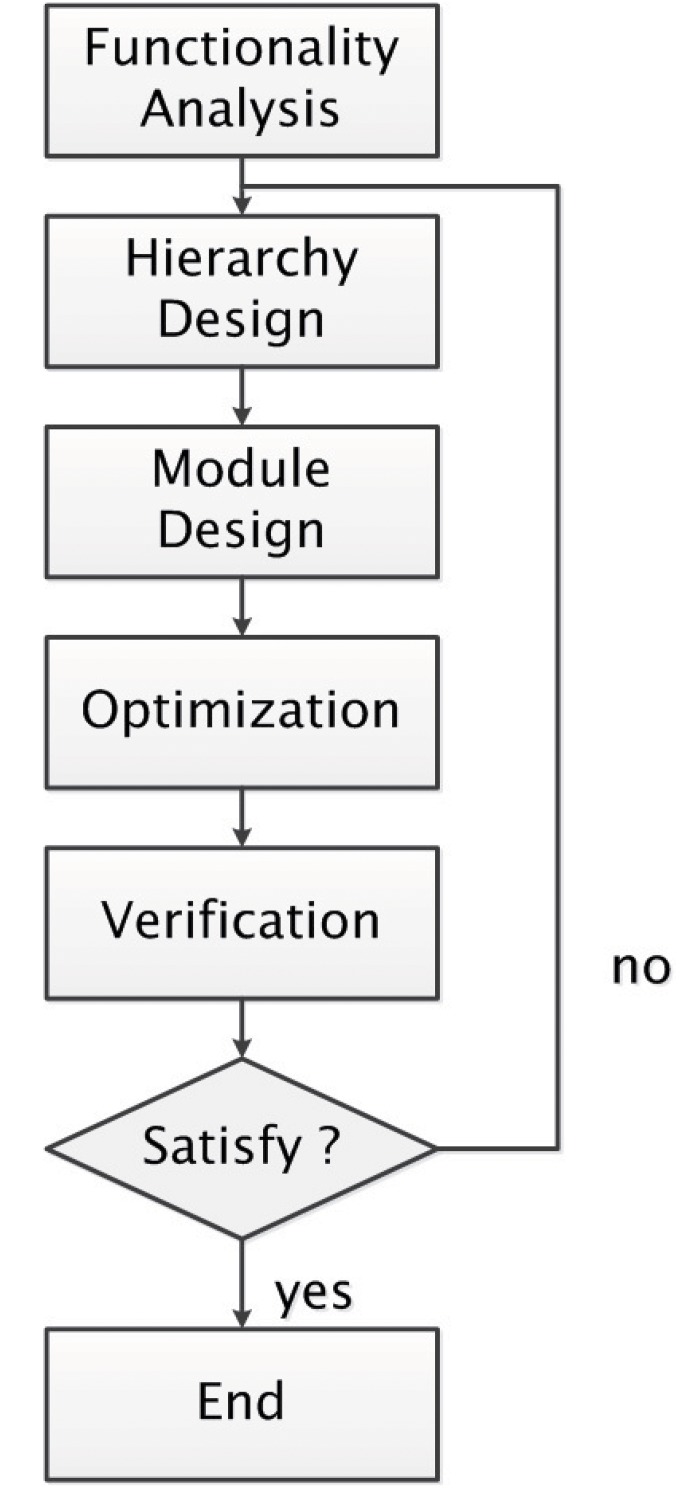
Flow of our method.